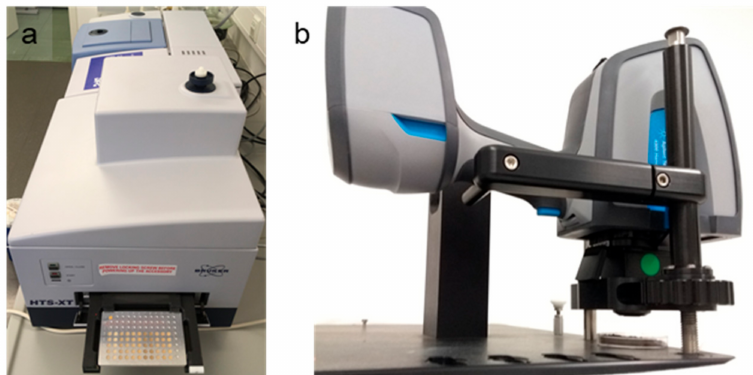
Figure 1. Mid-infrared spectrometers (MIRS) used for spectra acquisition ( a ) benchtop MIRS Bruker Tensor 27 ( b ) portable MIRS Agilent